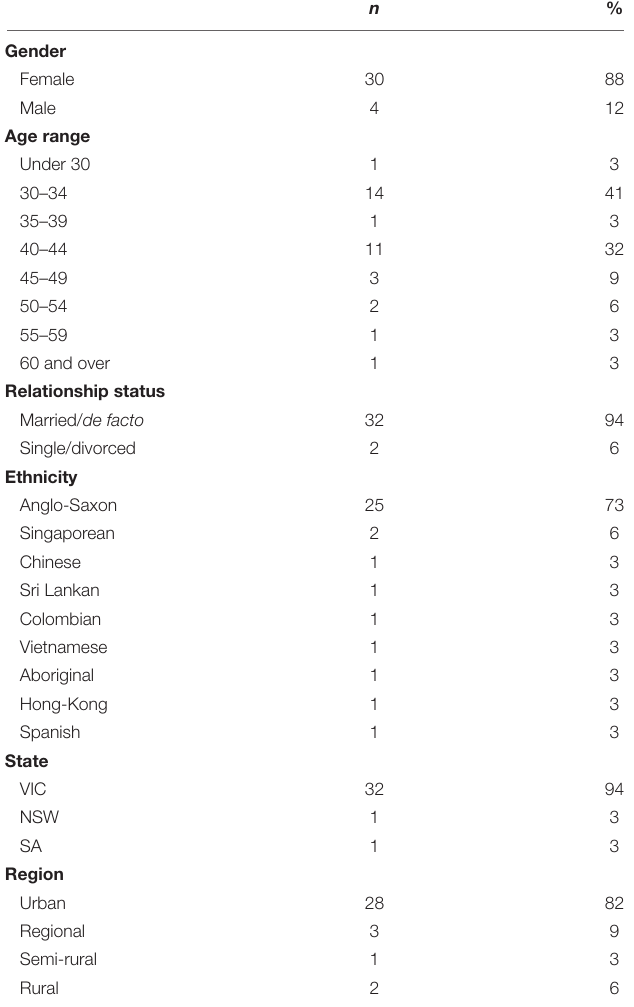
TABLE 2 | The impacts of COVID-19 on family functioning: superordinate and subordinate themes. Superordinate